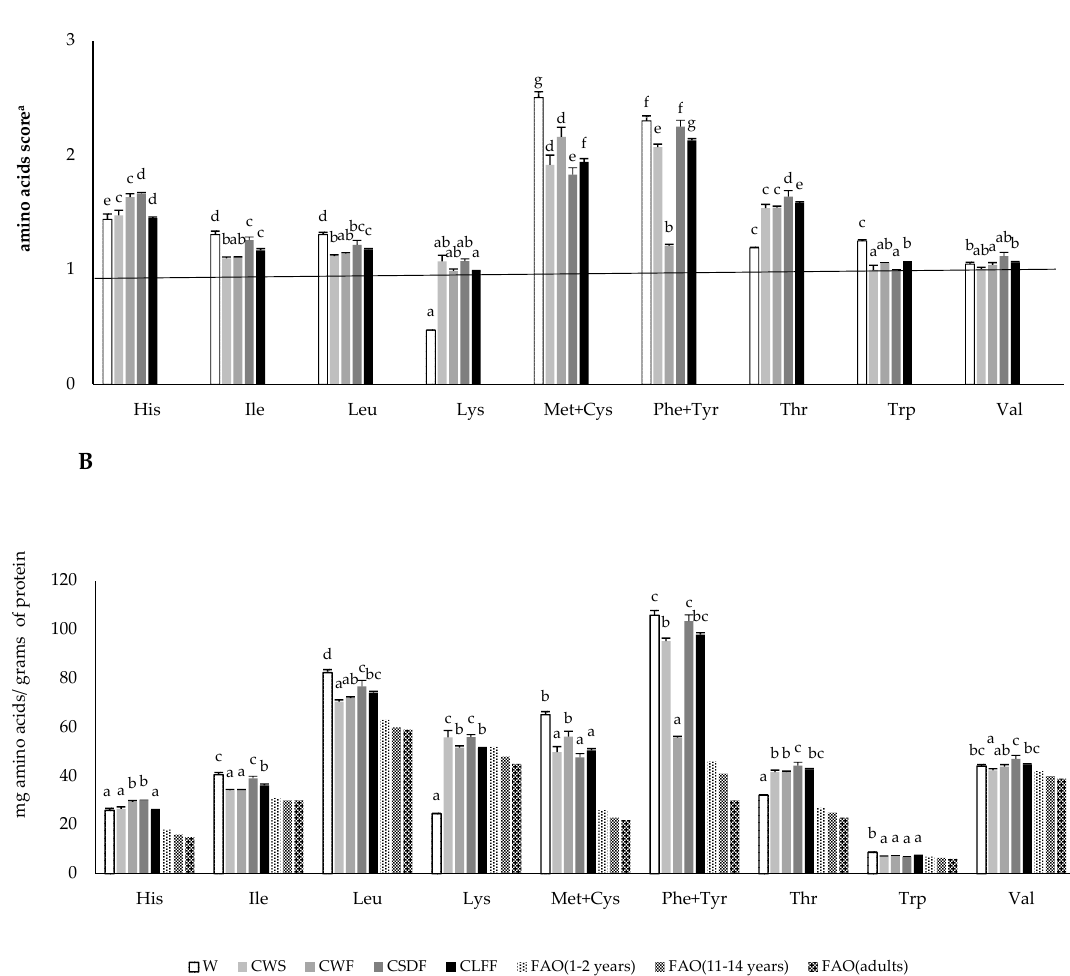
Figure 1. Evaluation of essential amino acids in chia ingredients. ( A ) Amino acids score (mg / g protein): essential amino acid pattern requirement for children as high-quality protein. ( B ) Composition of amino acids (mg / g protein d.m.): based on FAO / WHO / UNU (Food and Agriculture Organization / World Health Organization / United Nations University) standard (2007), 1–2-year-old reference pattern (mg / g protein): His-18, histidine; Lys-52, lysine; Ile-31, isoleucine; Leu-63, leucine; Met + Cys-26, methionine + cysteine; Phe + Tyr-46, phenylalanine + tyrosine; Thr-27, threonine; Trp-7, Tryptophan; Val-42, Valine. Wheat flour (W); CWS, whole chia seed; CWF, whole chia flour; CSDF, semi-defatted chia flour; and CLFF, low-fat chia flour. Values are expressed as mean ± standard deviation ( n = 3). Bars followed by the same letter are not significantly different at 95% confidence level.